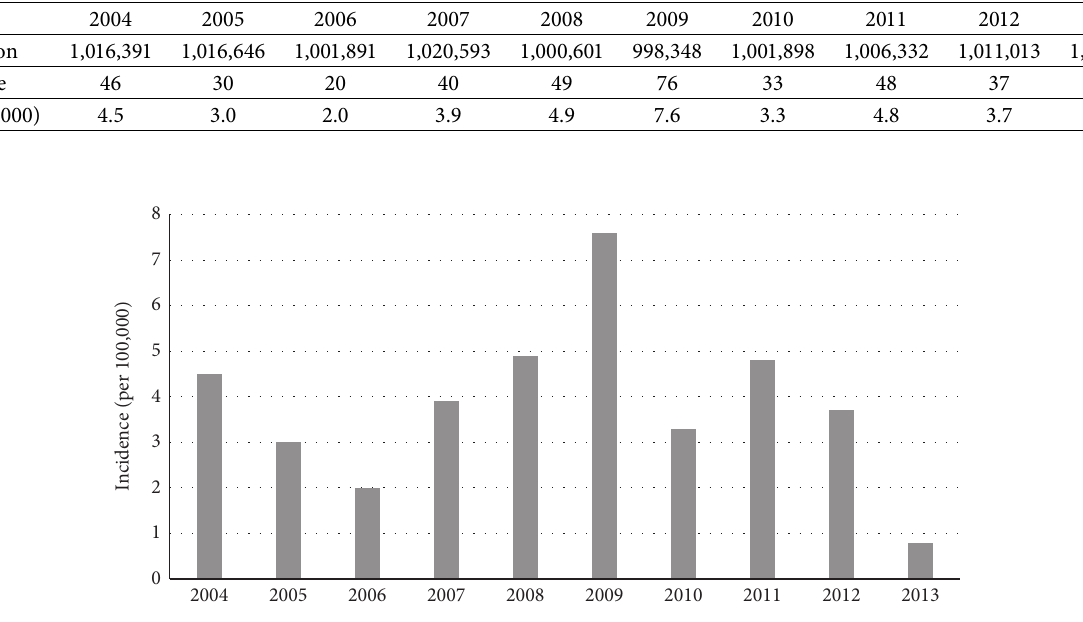
Figure 1: Incidence of keratoconus from 2004 to 2013 in